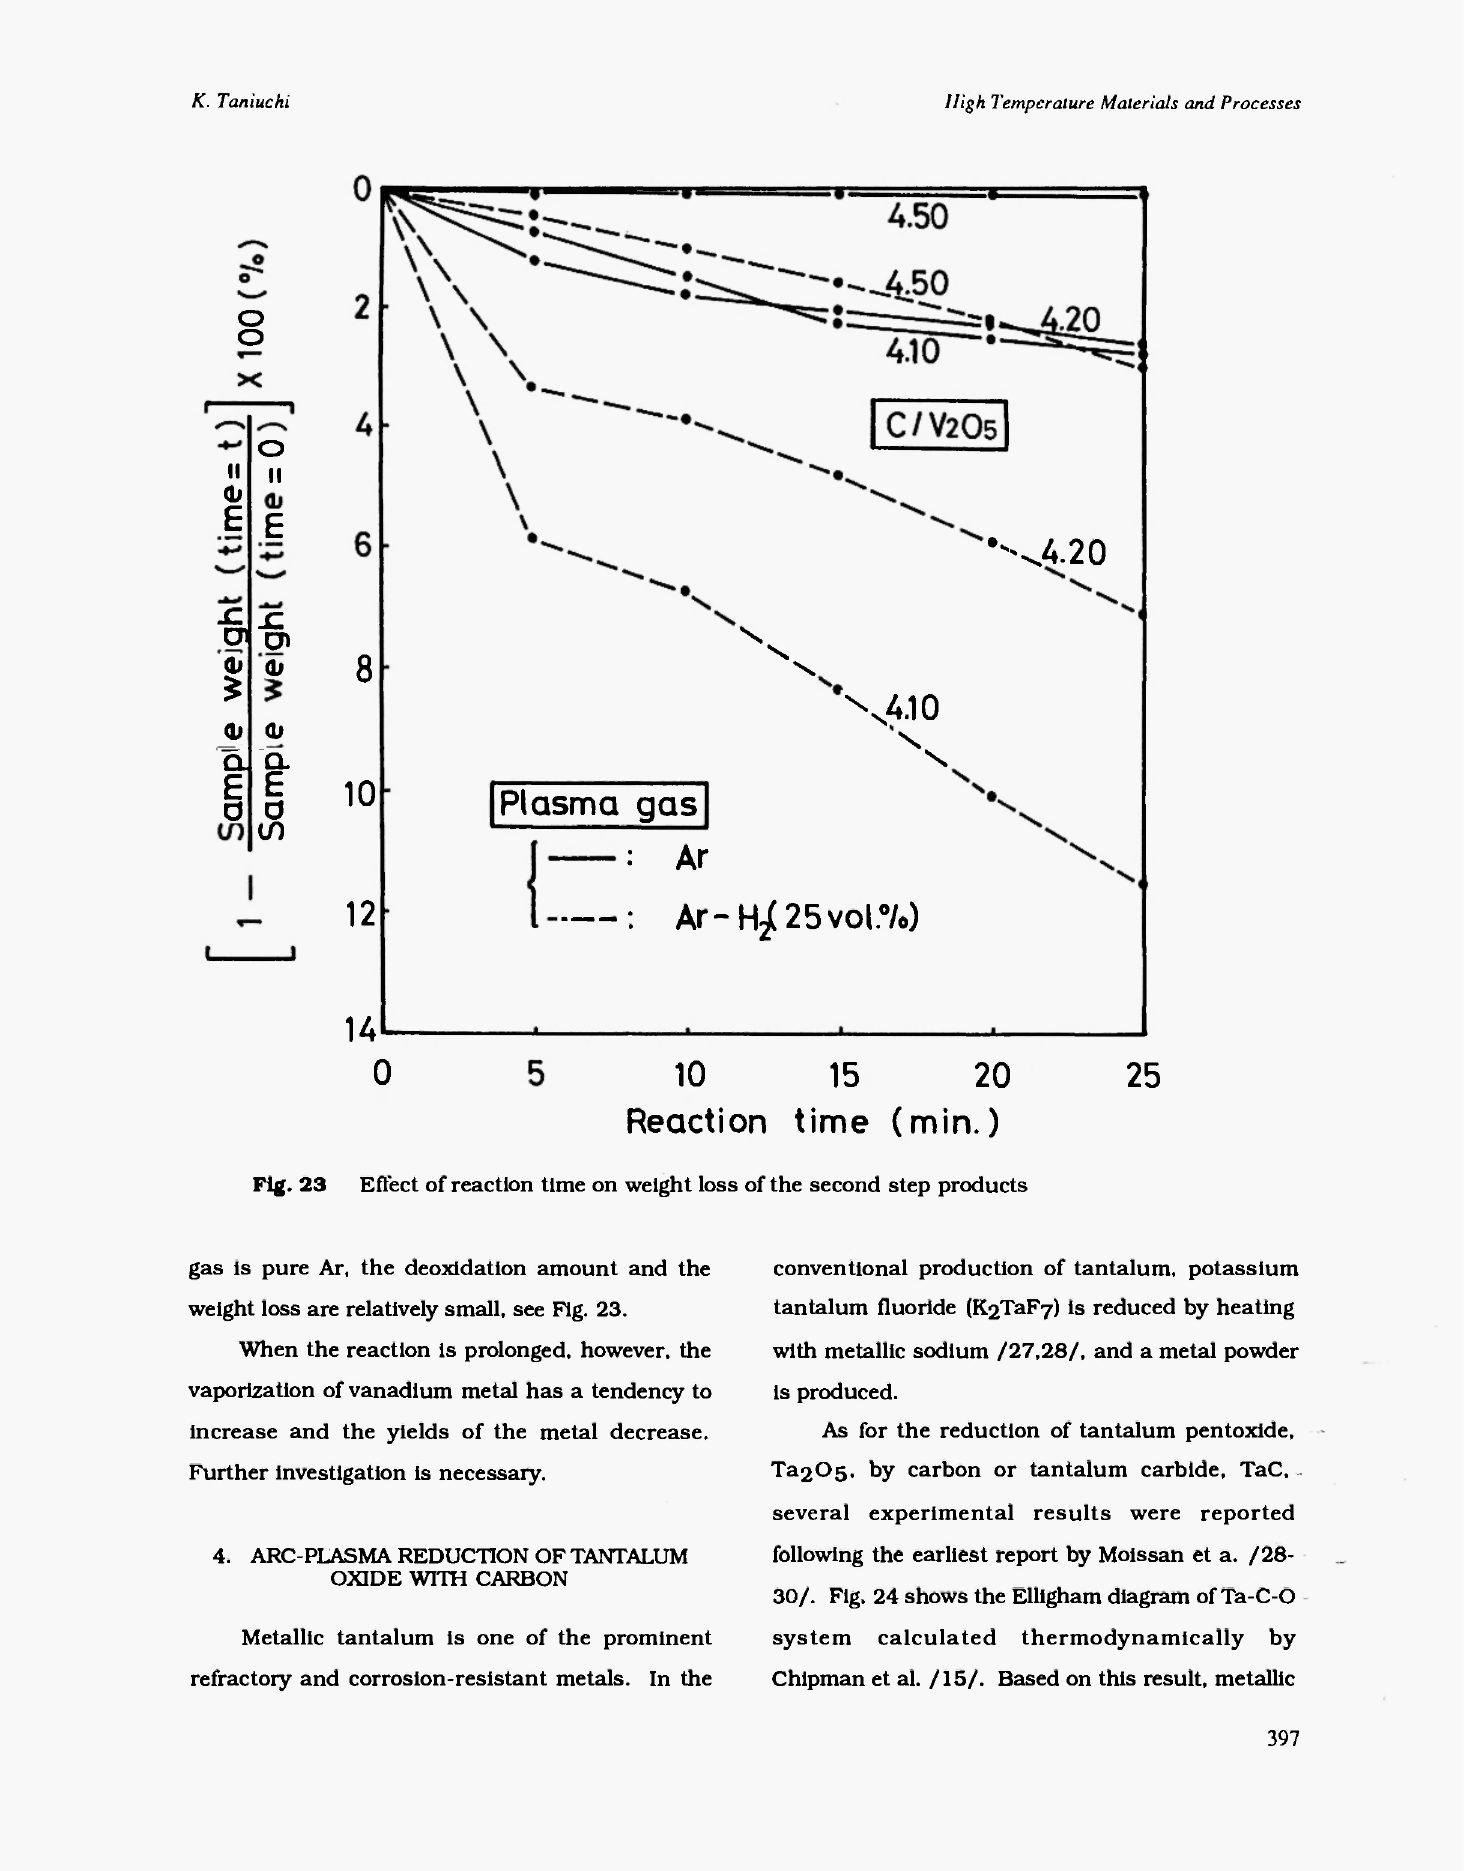
Effect of reaction time on weight loss of the second step